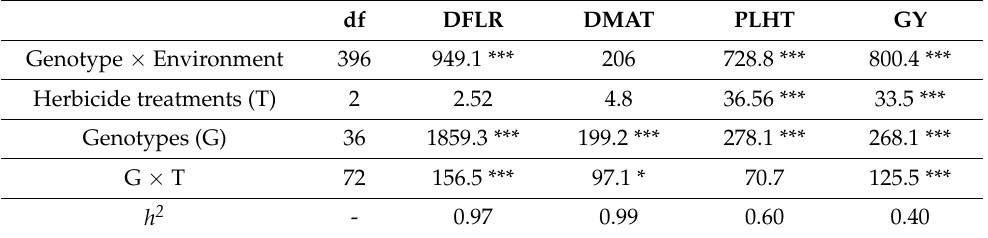
Table 1. Combined analysis performed for detecting Wald statistics and differences among faba bean genotypes, treatments, and genotypes x treatment interaction for phenological and agronomic traits across